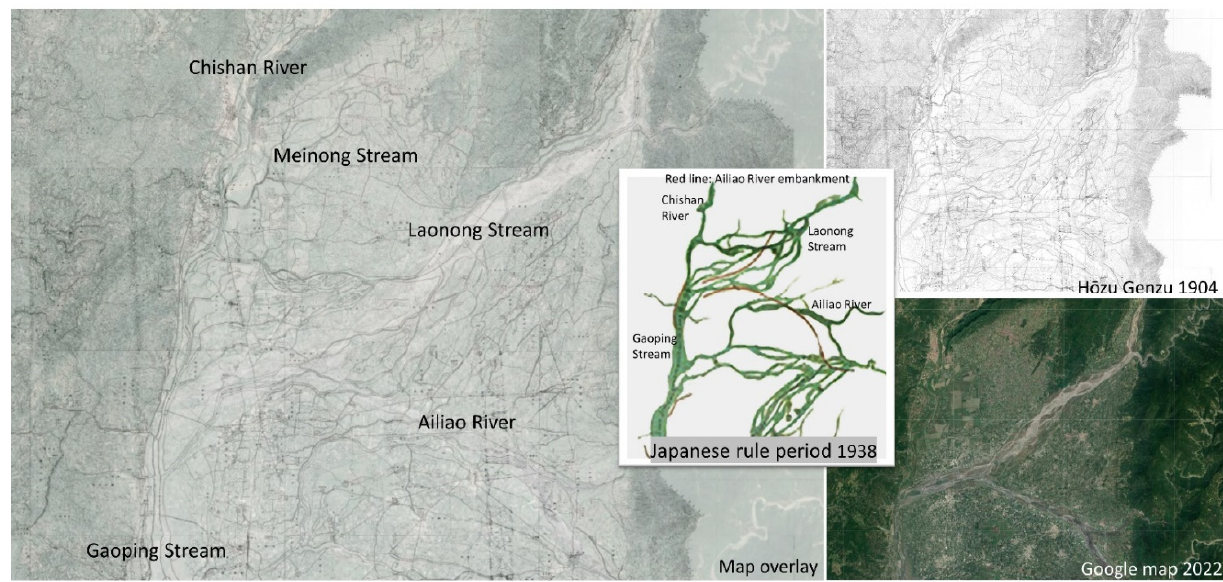
Figure 4. Overlay map of drainage system changes in Meinong Plain (1904–1938) .